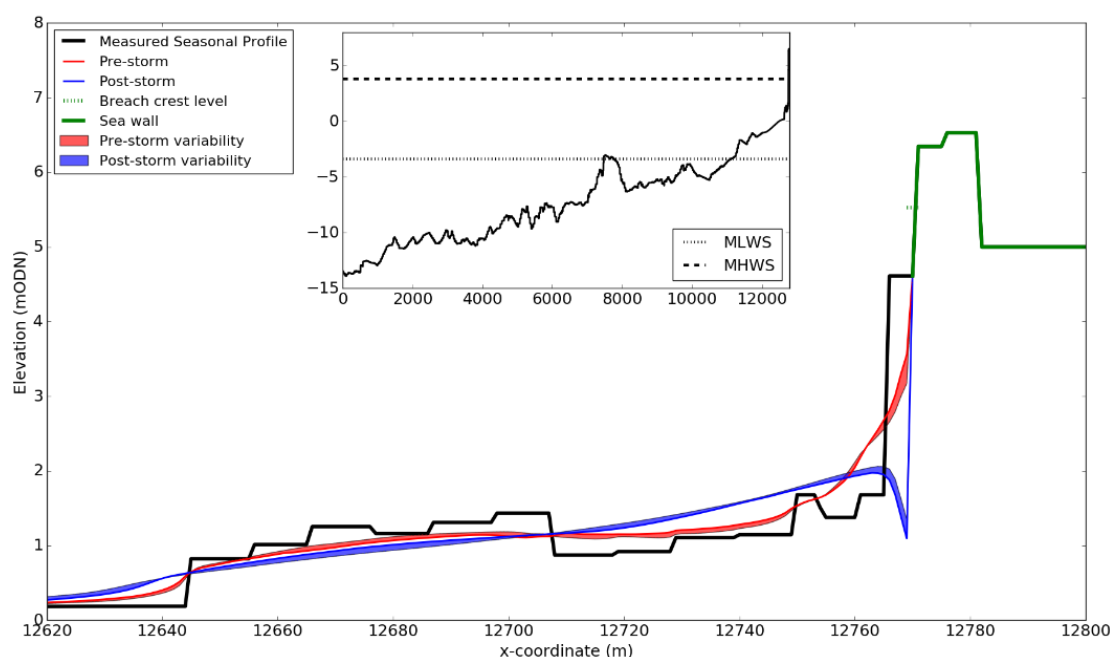
Figure 3. Applied 1D transect in XBeach, with all considered initial bathymetries. The post-storm variability (blue shading) shows the difference between the lowest (Scenario 4, Table 1, selected profile) and highest (Scenario 1, Table 1) elevation at the sea defence toe. The pre-storm variability (red shading) shows the difference between the lowest (Scenario 4) and highest (Scenario 1) elevation at the sea defence crest toe. Mean high water spring (MHWS) and mean low water spring (MLWS) tidal elevations are provided by